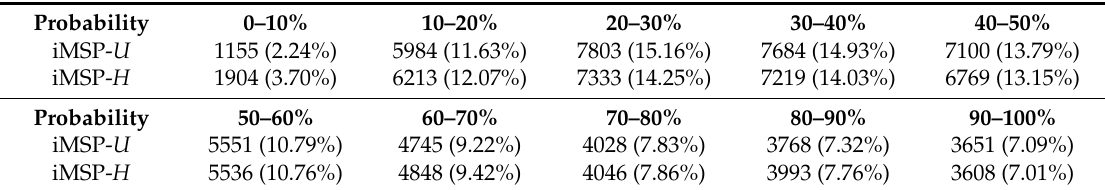
Table 6. Predicted probabilities to be potential secreted proteins in human proteome.